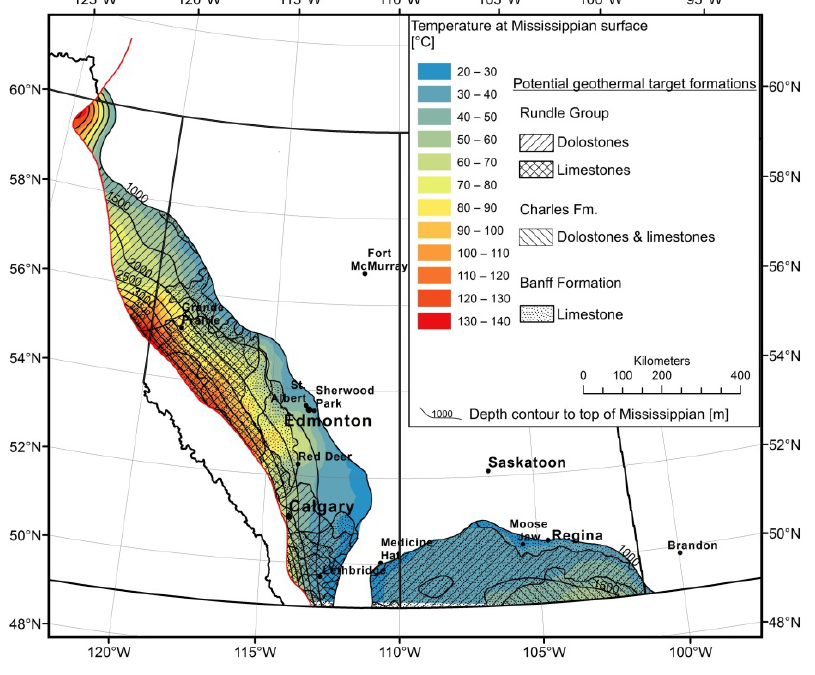
Figure 8. Temperature at the top of the Mississippian; formations outline from Richards et al.